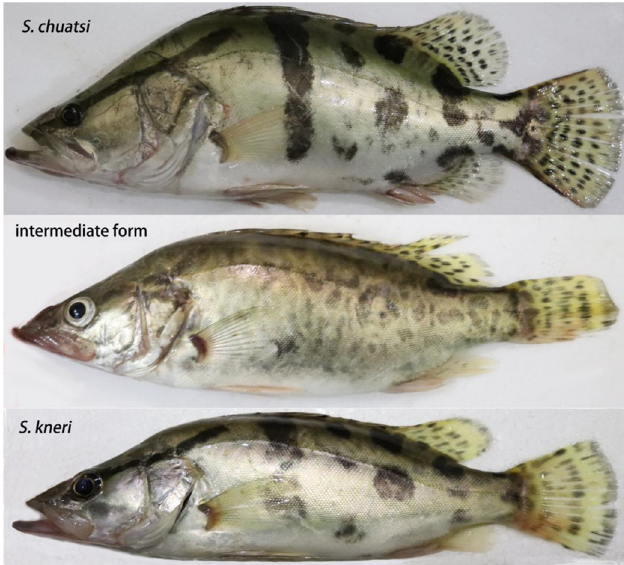
Fig. 1. Morphology of S.chuatsi, S.kneri and intermediate form (Zhu et al.,